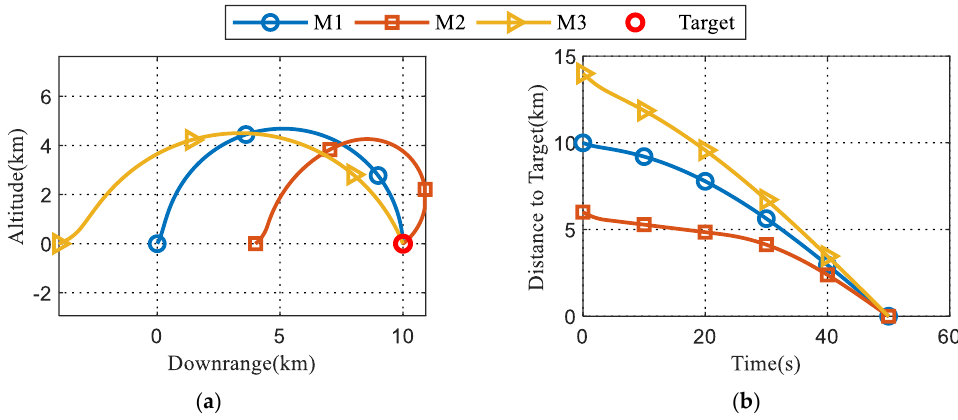
Figure 12. The results in a salvo attack. ( a ) Trajectories; ( b ) Distance to target.